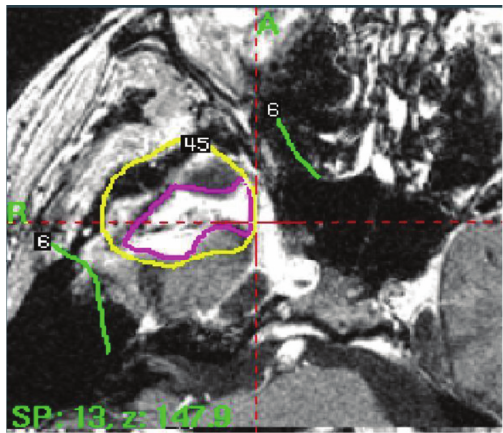
Figure 2: Gamma Knife treatment planning illustration of dose on an axial T1 postgadolinium MRI scan for the third Gamma Knife